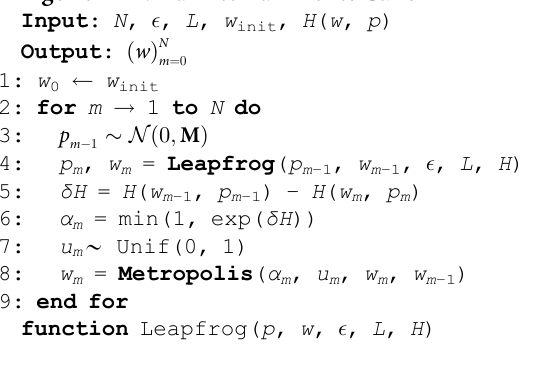
Algorithm 1 : Hamiltonian Monte